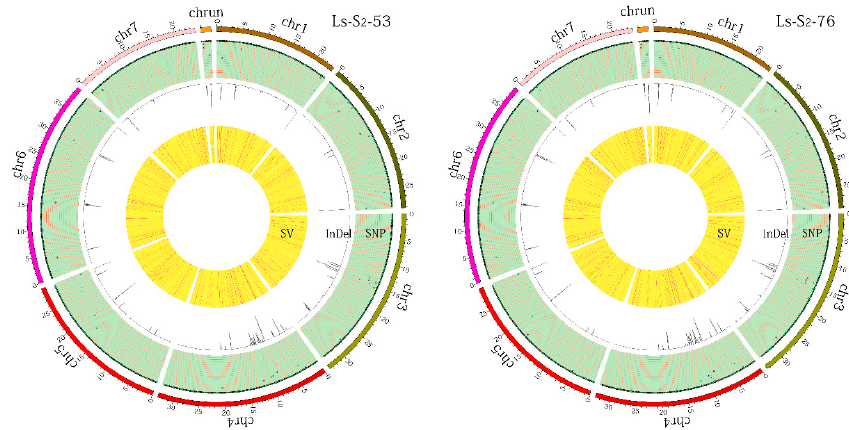
Figure 3. The distribution of DNA polymorphisms (single-nucleotide polymorphisms (SNPs), indels, structural variations (SVs)) in F. viridis resequencing samples Ls-S 2 -53 and Ls-S 2 -76, compared with the reference sample genome ( F. vesca ). The three rings, from outside to inside, represent all detected SNPs, indels, and SVs, respectively. The total variation distribution in the two sequencing samples is highly similar.